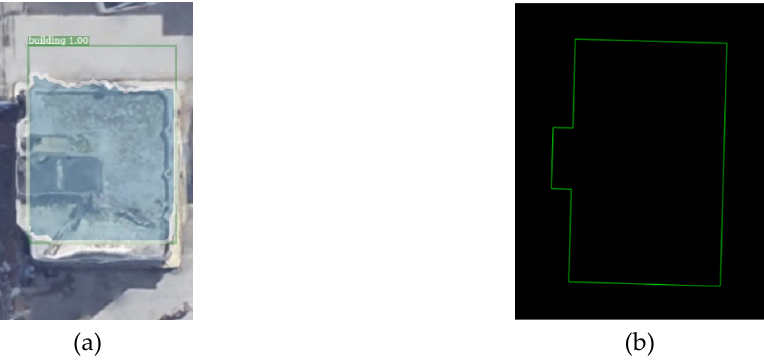
Figure 5. ( a ) Sharpness of the polygon, ( b ) building roof bounding box with mask.